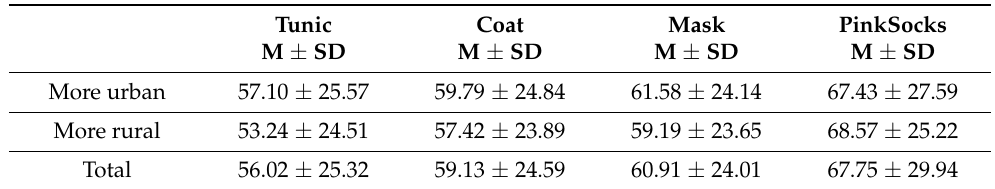
Table 7. Evaluation of the four photos by the two subgroups according to team participation and place of residence (mean, standard